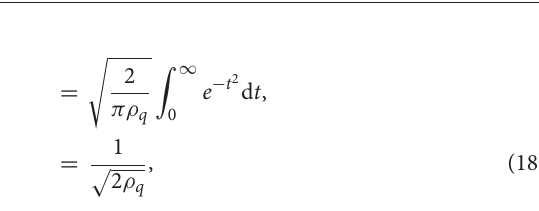
FIGURE 11 | Topological defects drive disorder in m > 1 modes. (A) Winding number charge q i for the soft modes of two independent simulation runs. Each SPP is colored according to its winding number and topological defects are centered on SPPs with q i 0. In both simulation runs the number of 6= topological defects increases with mode number. (B) The total absolute charge Q abs plotted against mode number m for 10 independent simulation runs shows the number of defects increases with increasing mode number. (C) Scatterplot of the total absolute charge Q abs vs. correlation length l c for each mode of the 10 independent runs (circles) compared to the parameter-free predicted estimate from our geometric argument